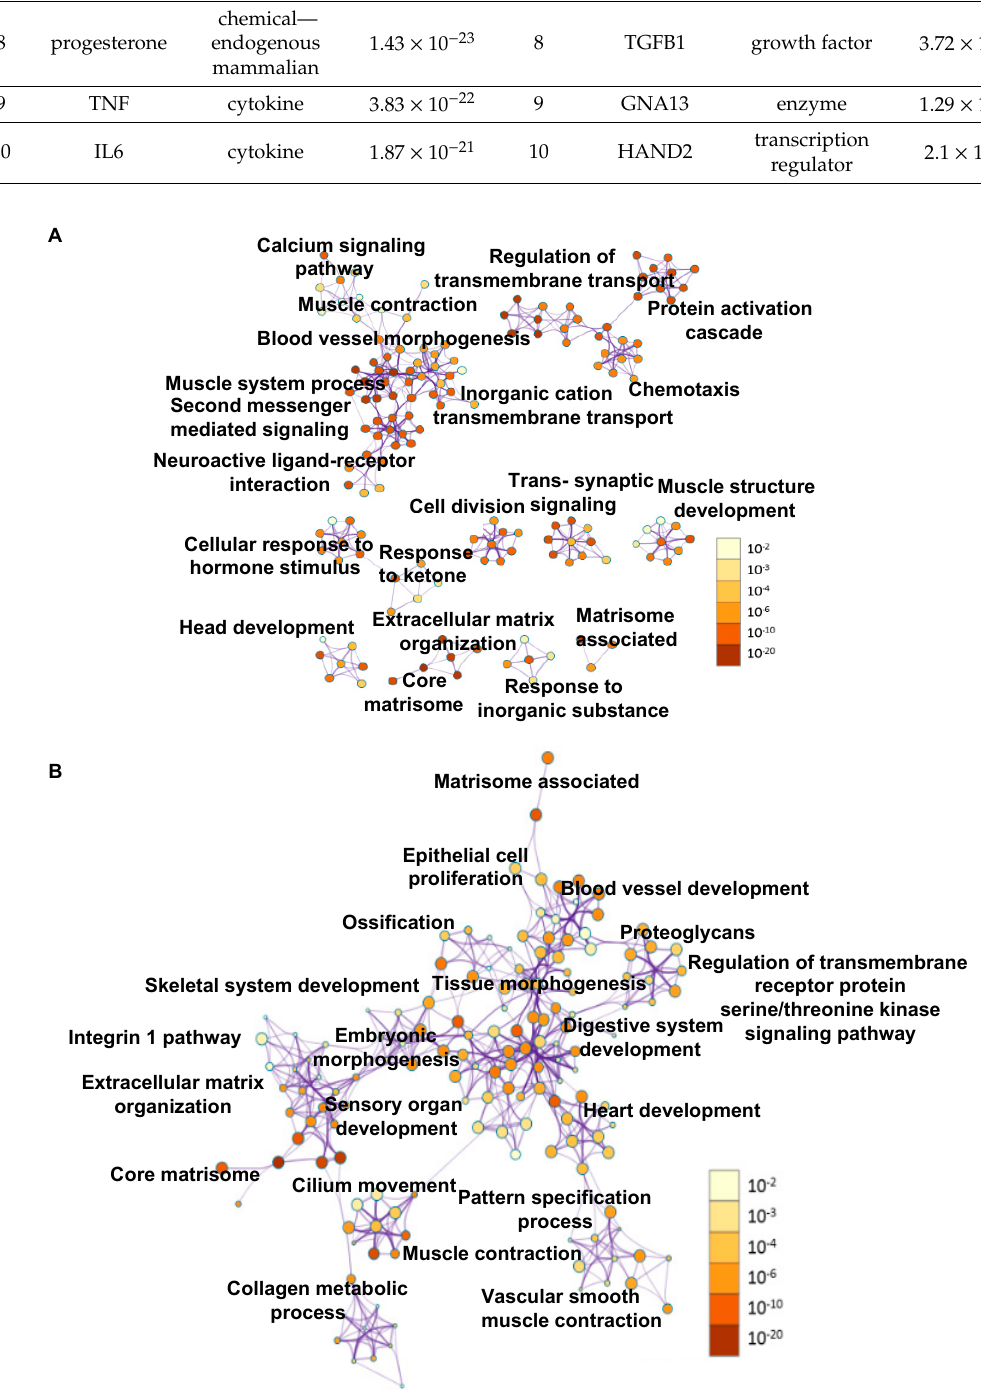
Figure 2. Pathway analysis of deregulated genes. ( A ) Pathway analysis for all deregulated genes in primary tumors versus fallopian tube. The interaction modules are clustered on the basis of functional similarities. ( B ) Pathway analysis for all deregulated genes in metastasis versus primary tumors with interaction modules clustered based on functional similarities. The node color intensity corresponds to the gene enrichment for a particular pathway and the node size correlates with statistical significance.